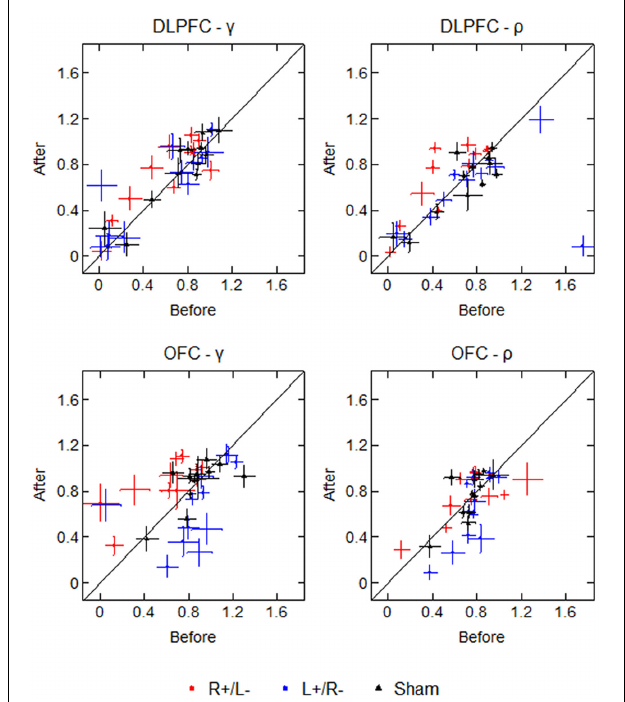
FIGURE 6 | Parameter values and bootstrap errors before and after the stimulation in different treatments. Each marker represents a single participant’s parameter value, with crosses representing the bootstrap standard